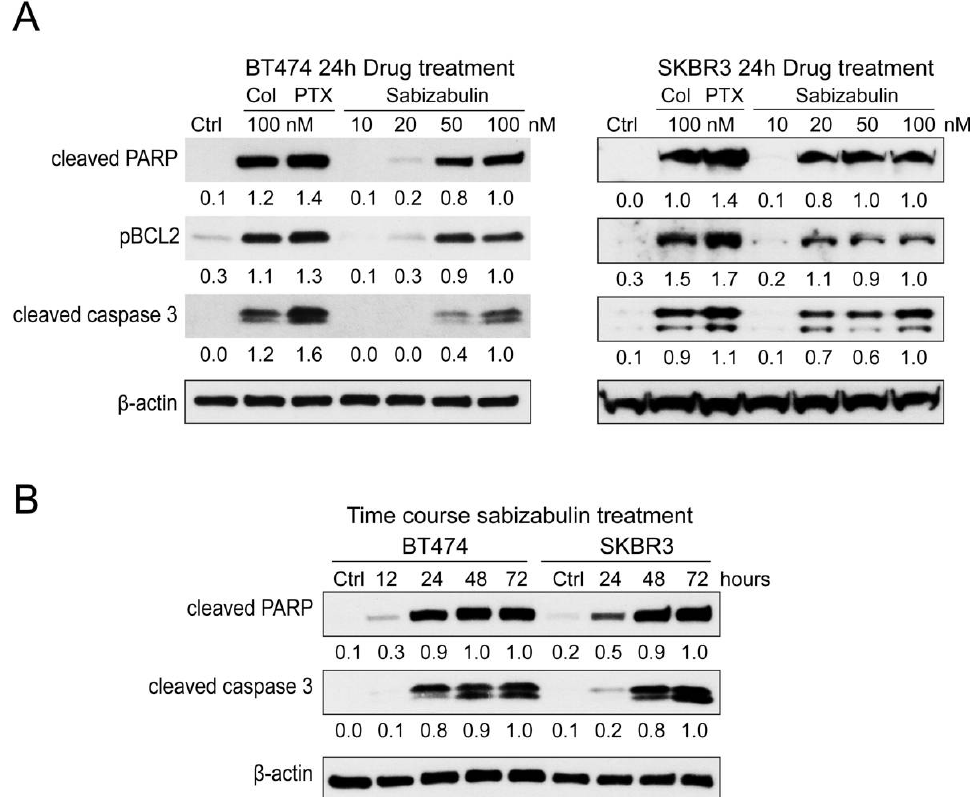
Figure 3. Sabizabulin induces apoptosis in BT474 and SKBR3 cells in a concentration-dependent manner. ( A ) A panel of apoptotic markers was profiled by western blotting after 24 h of treatment with colchicine or paclitaxel (100 nM) or sabizabulin (10, 20, 50, or 100 nM) in BT474 and SKBR3 cells. Signal from cleaved-PARP (anti-cleaved-PARP, CST 5625, 1:1000), phosphorylated BCL2 (pBCL2; anti-pBCL2, 2827 CST 1:1000) and cleaved caspase-3 (CST 9661, 1:500) was first normalized to β-actin (CST 3700, 1:20,000) by ImageJ densitometry, with the 100 nM sabizabulin-treated lane set to 1.0. ( B ) Cleaved-PARP and cleaved-caspase-3 levels in both HER2+ cell lines were determined by western blotting after treatment with 100 nM of sabizabulin for 12, 24, 48, and 72 h after normalization to β-actin. Data are representative of three independent biological replicate assays.